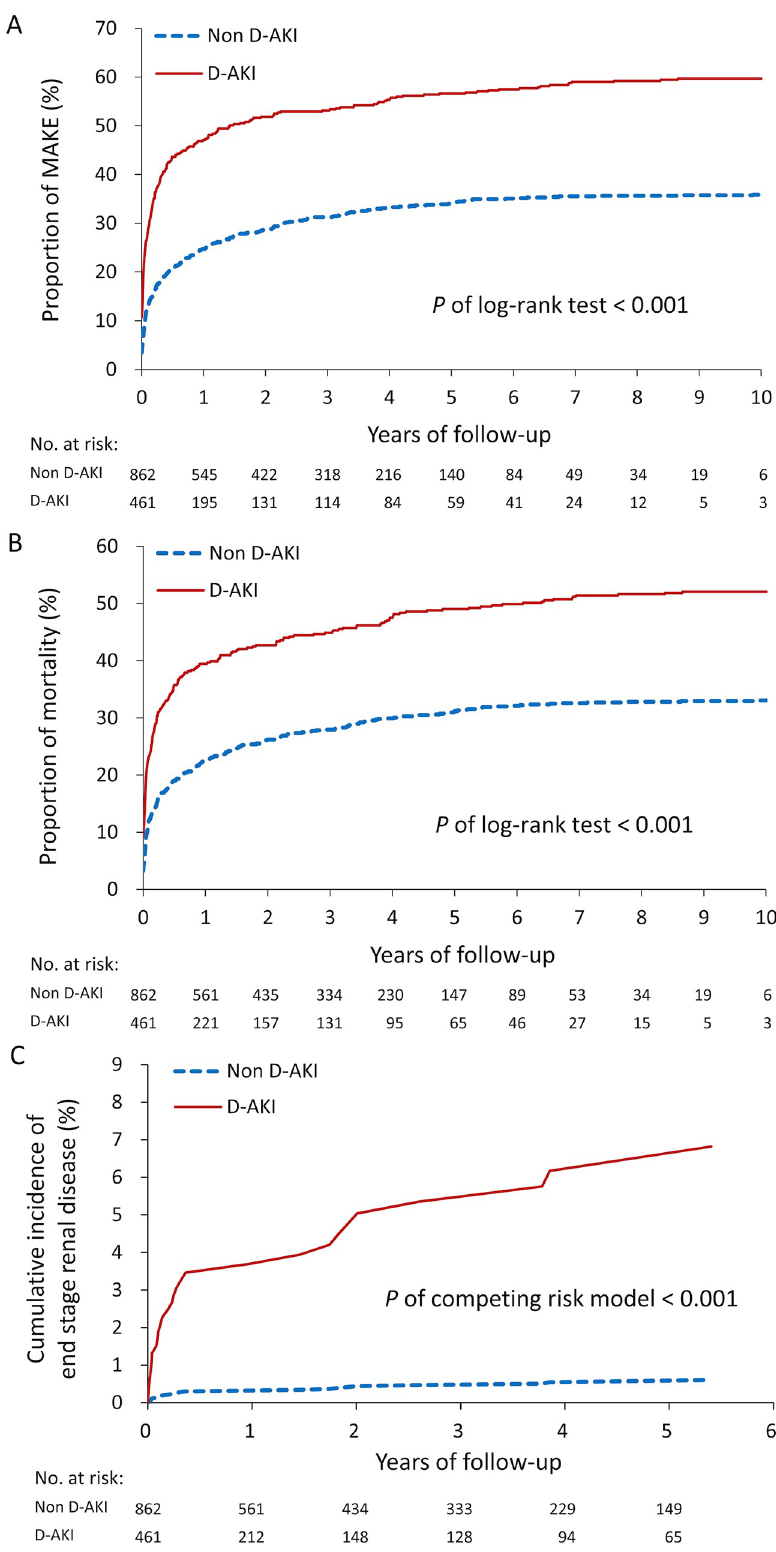
Fig 4. Proportion of major adverse kidney events (A) and all-cause mortality (B), cumulative incidence of end stage renal disease (C) during follow-up in the D-AKI and non D-AKI patients. https://doi.org/10.1371/journal.pone.0212352.g004 PLOS ONE | https://doi.org/10.1371/journal.pone.0212352 March 13,